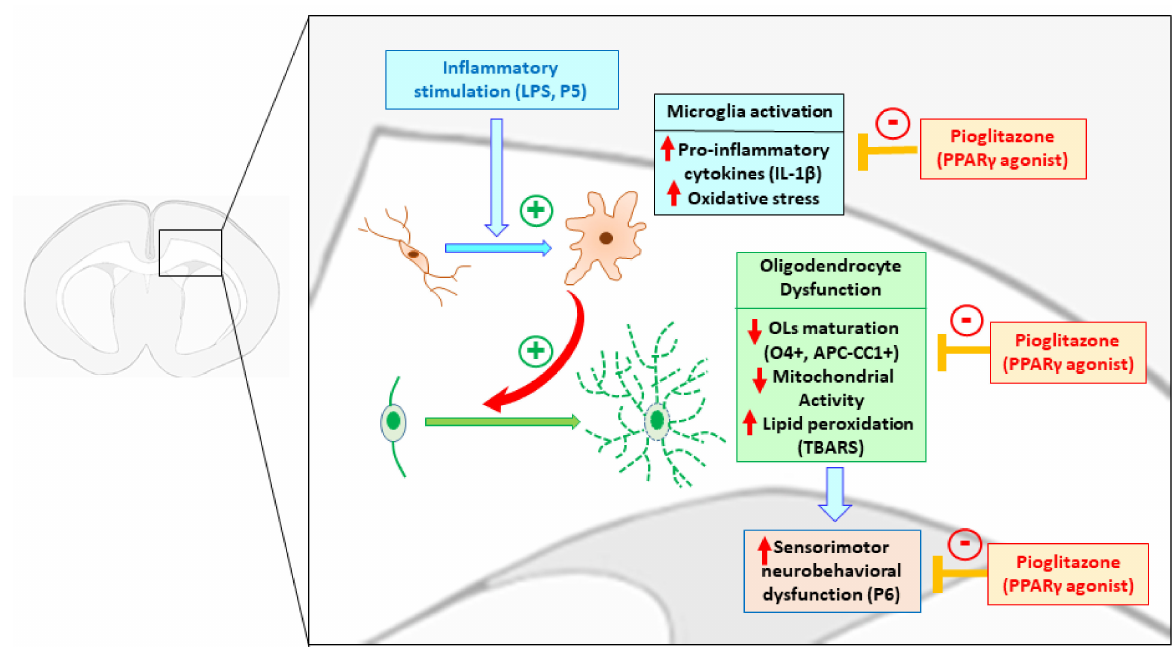
Figure 10. Schematic illustration of microglia-oligodendrocytes interaction in the brain white matter in neonatal systemic inflammation-induced sensorimotor neurobehavioral dysfunction. Systemic lipopolysaccharide (LPS) exposure led to stimulation of microglia activation, induction of pro-inflammatory cytokine interleukin-1 β (IL-1 β ), loss of oligodendrocyte lineage cells (O4+/APC-CC1+) and mitochondria activity, and upregulation of lipid peroxidation which caused brain white matter injury and related sensorimotor neurobehavioral dysfunction in neonatal rats. Treatment with peroxisome proliferator-activated receptor gamma (PPAR γ ) agonist pioglitazone reduces LPS-induced loss of oligodendrocytes and mitochondrial activity, and sensorimotor neurobehavioral dysfunction, which was associated with attenuation of LPS- induced increment of thiobarbituric acid reactive substances (TBARS) contents, IL-1 β levels and number of activated microglia in neonatal rats. These findings suggest that PPAR- γ agonist pioglitazone may be useful for therapeutic effects in neonatal white matter disease with its properties of anti-inflammation, anti-oxidation, promoting of oligodendrocyte progenitor cell differentiation, and mitochondrial cell survival